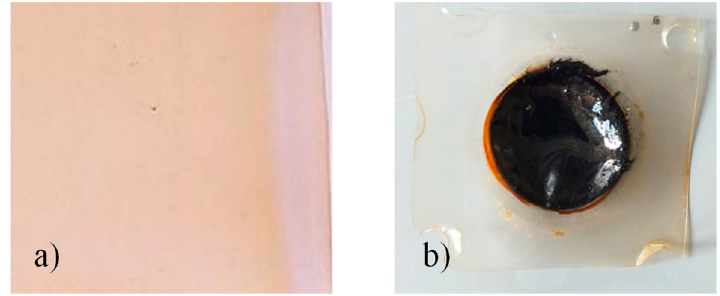
Figure 2. Nafion membrane at ( a ) day 0 and ( b ) after 30 days of operation.